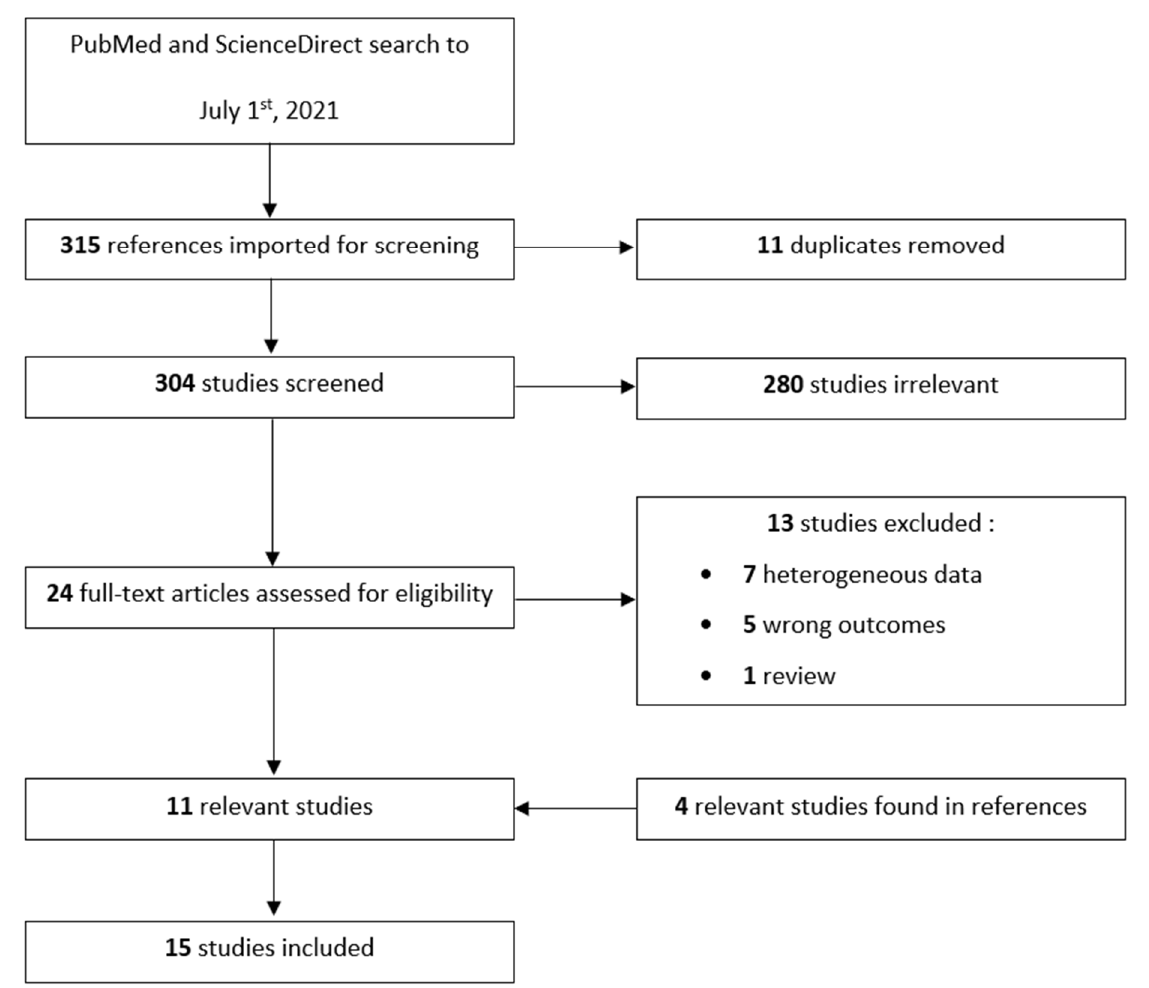
Figure 1. PRISMA flowchart of the literature search and study selection process.